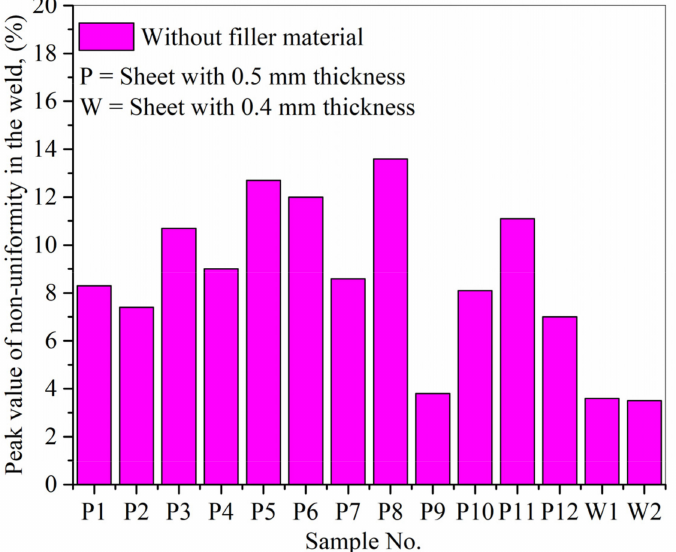
Figure 15. The peak value of non-uniformity was calculated via X-ray analyses for laser welds without filler material.